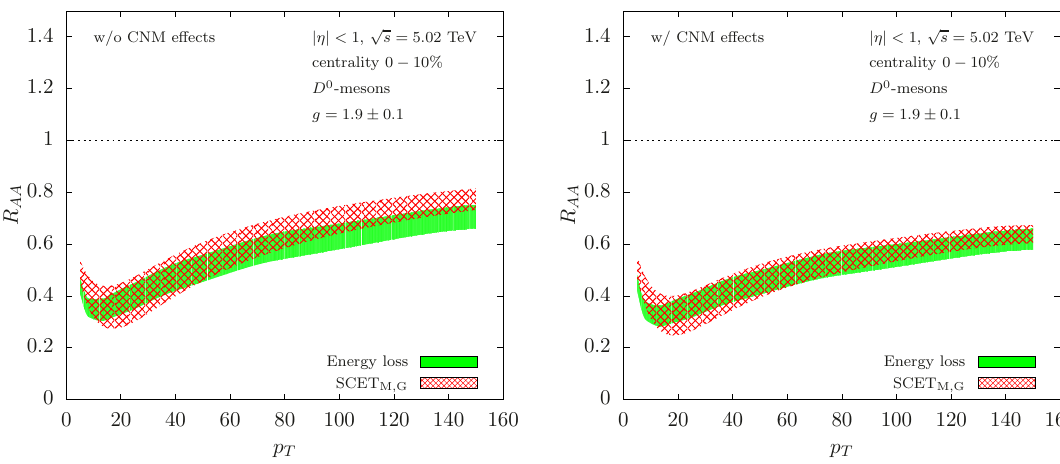
Figure 9 . The nuclear modi(cid:12)cation factor R AA for D 0 meson production as a function of the transverse momentum p T . We show the result obtained within the traditional approach to energy loss (green band) as well as the new results based on SCET M ; G (hatched red band). We choose a p CM energy of s NN = 5 : 02 TeV, a rapidity interval of 0 < j (cid:17) j < 1 and the results are for central collisions with centrality 0 (cid:0) 10%. In addition, we choose the coupling strength as g = 1 : 9 (cid:6) 0 : 1. The results for R AA are presented without CNM e(cid:11)ects (left) and with CNM e(cid:11)ects (right). See text for more